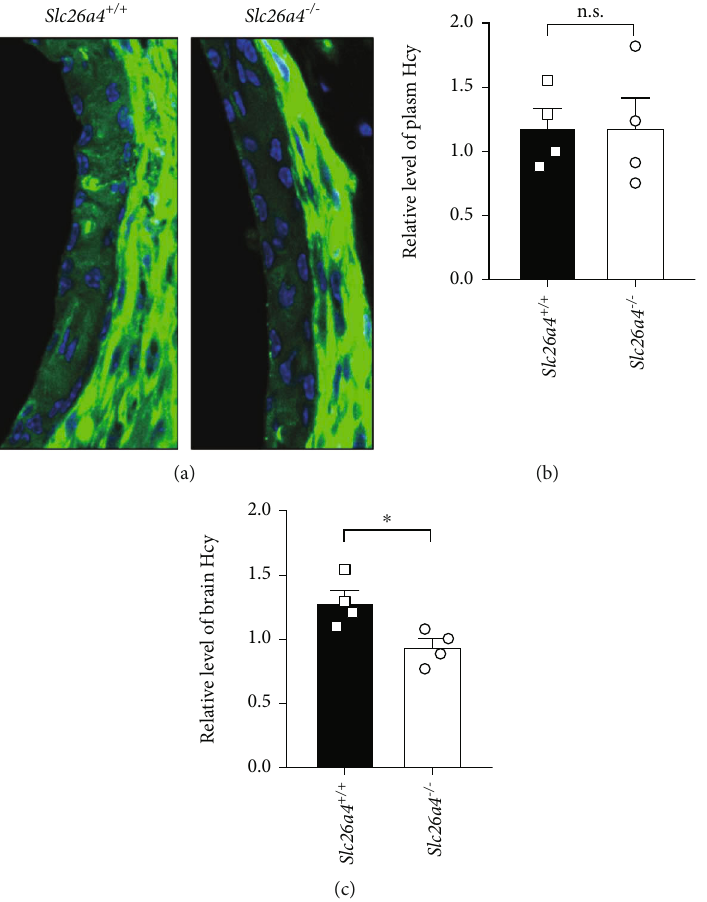
Figure 6: Altered Hcy metabolism in Slc26a4 -/- SVs. (a) Stria vascularis from wildtype or Slc26a4 -/- mice were coated on coverlips and sent for immunostaining against Hcy. (b, c) Elisa assay of Hcy level in plasma (b) and brain (c) from wildtype or Slc26a4 -/- mice. n.s.: no signi fi cance. ∗ p < 0 : 05 by the unpaired t -test (b, c). Data are from three independent experiments with biological duplicates in each (a, b, c; mean ± s : e : m : of n = 3